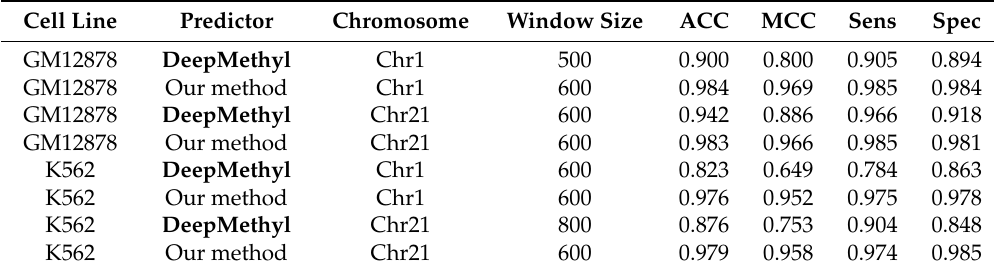
Table 6. Comparison with DeepMethyl